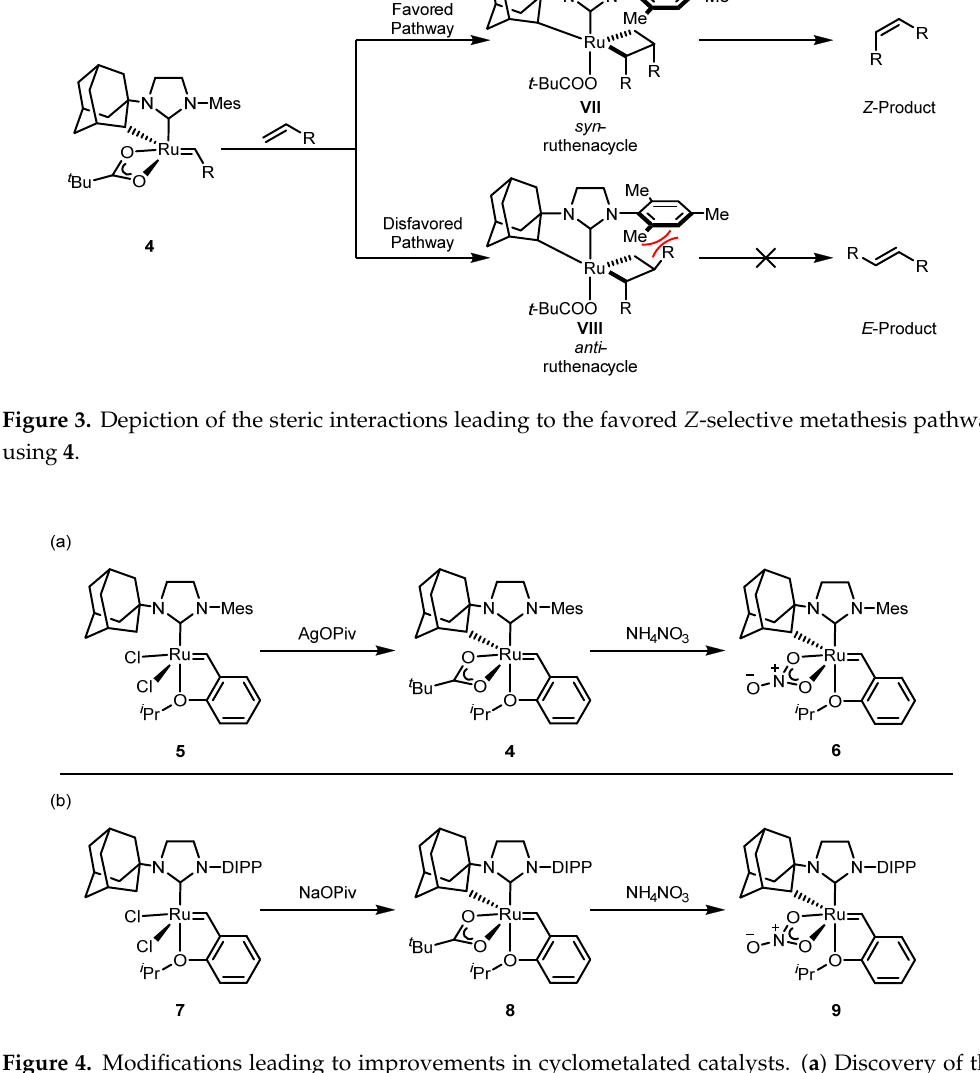
Figure 4. Modifications leading to improvements in cyclometalated catalysts. ( a ) Discovery of the nitrate ligand enhanced the performance of 6 ; ( b ) Employing the N -2,6-diisopropylphenyl (DIPP) group further improved the reactivity and selectivity of the cyclometalated catalysts.